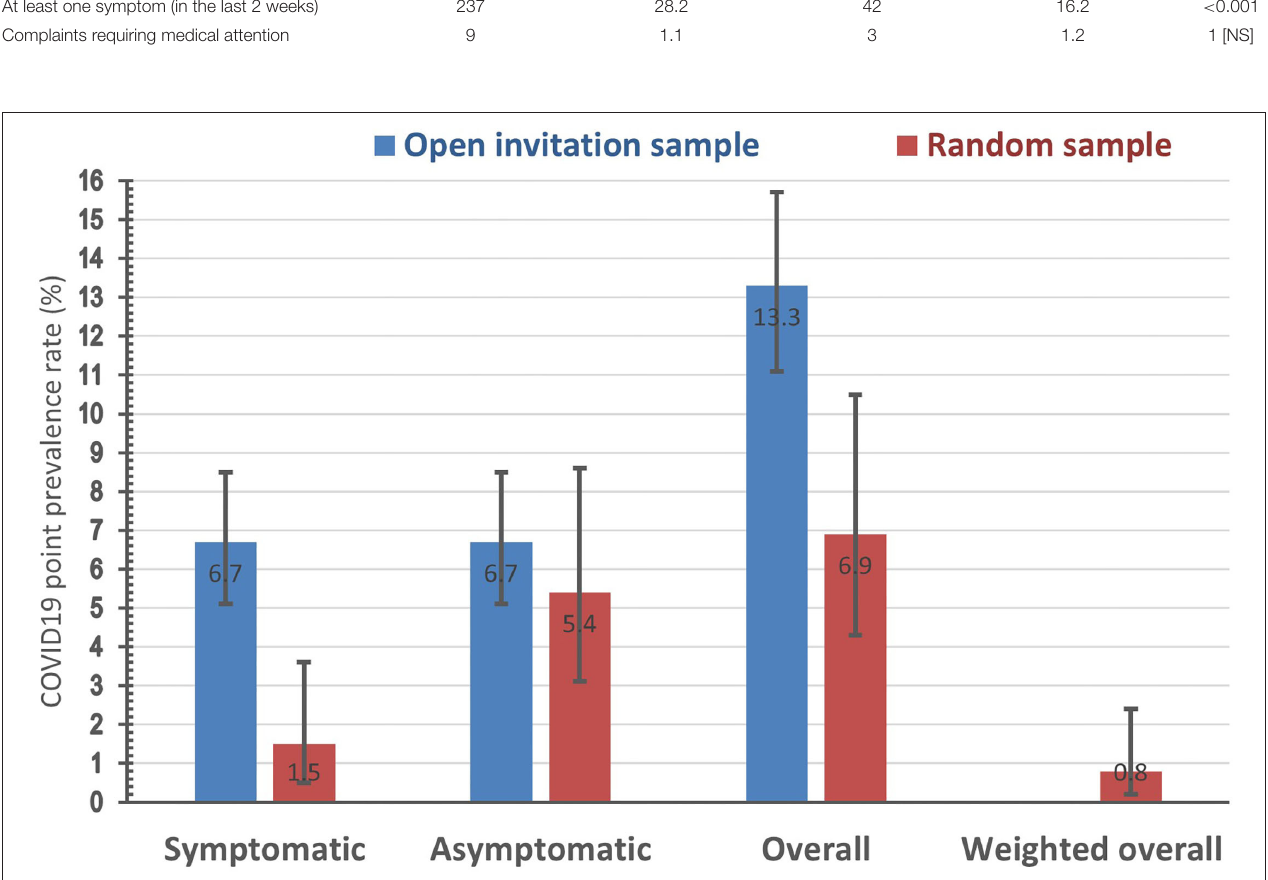
FIGURE 1 | Point prevalence rate (with its 95% confidence interval) of positive rtPCR COVID-19 test in two study samples by symptoms status.